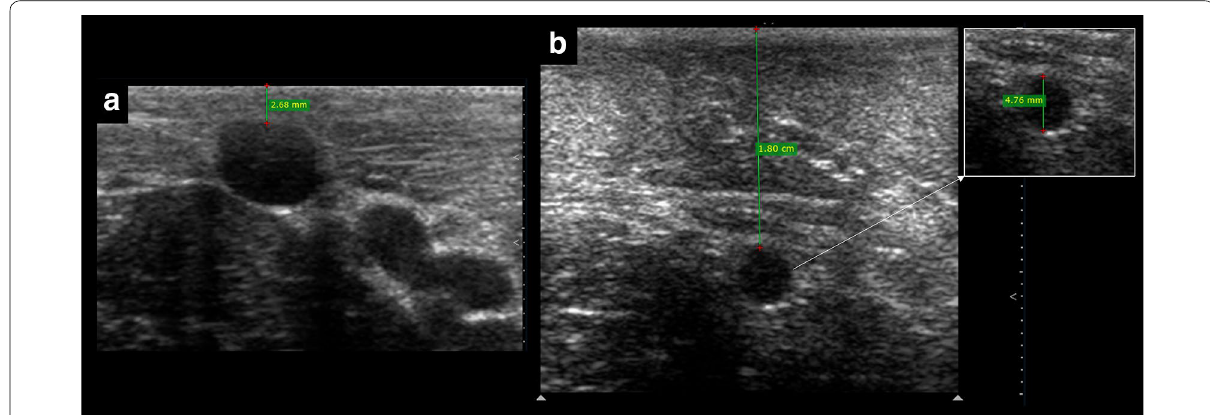
Fig. 5 Distance from skin to vein for US-guided cannulation. In a , it is < 12 mm (ideal), while in b is > 16 mm. Since the vein in b has a diameter > 4 mm, it could still be cannulated using longer catheters than usual, for example, a midline